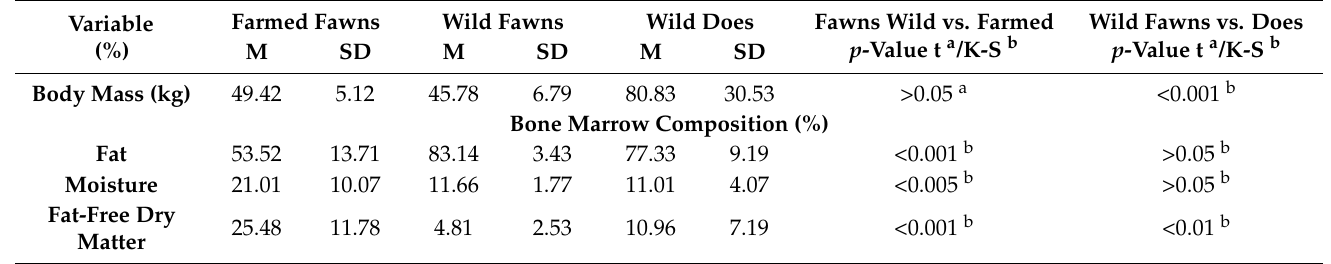
Table 1. Comparison of the mean body weight, bone marrow composition between red deer fawns and